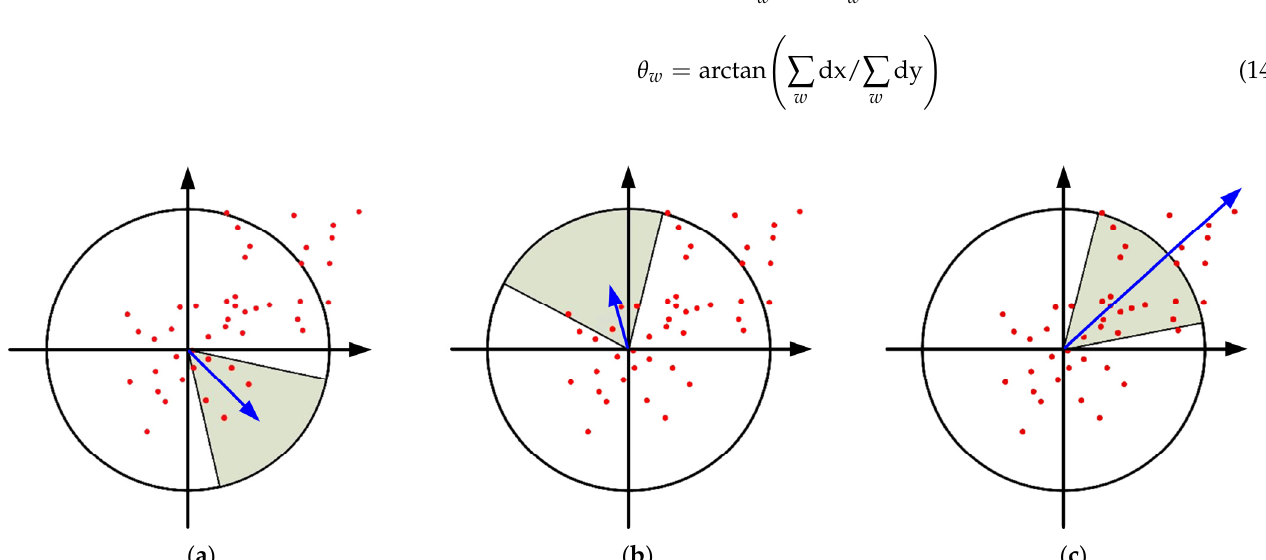
Figure 8. Determination of the main direction of the ARAC feature point. Take the feature point as the centre and slide the sector with an opening angle of 60°: ( a ) general vector length; ( b ) minimum vector length; ( c ) the main direction whose victor is the largest.